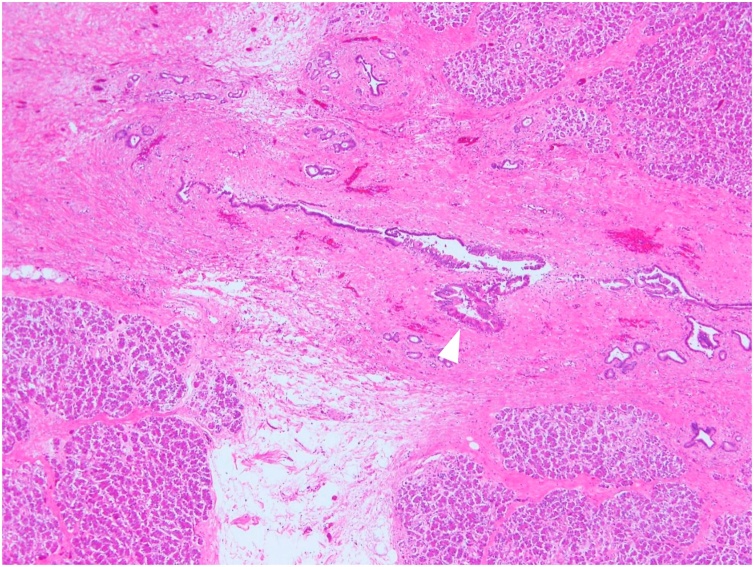
Histopathological findings of surgical specimen showing scattered foci of grade IB pancreatic intraepithelial neoplasia (hematoxylin-eosin staining, x100) (a white arrow).